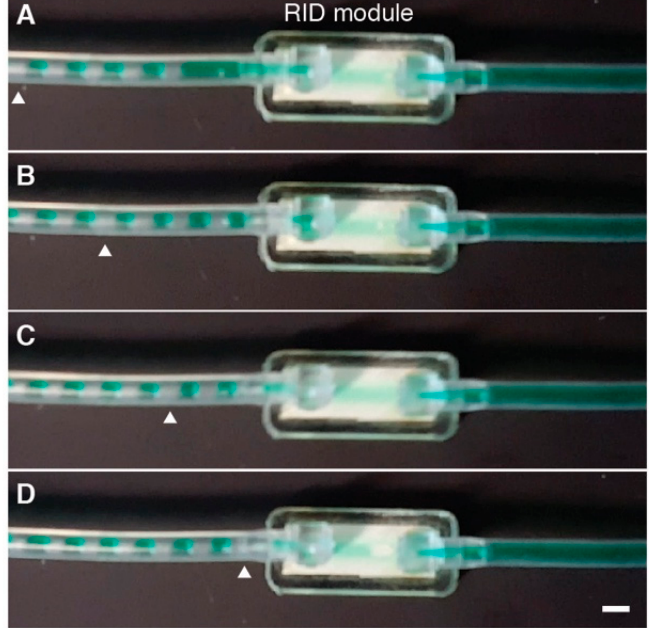
Figure 4. Sequential frames A-D extracted from video showing bubble removal from an incoming segmented flow stream (bubble volume = 2.2 ± 0.3 µ L, Q = 1.1 mL min − 1 , and V b :V T = 0.4). Flow is left to right. ( A ) White arrow highlighting bubble at left edge of frame, t = 0 s. ( B ) Segmented flow moving down tube toward RID, t = 0.73 s. ( C ) Bubbles upstream of highlighted bubble enter RID, t = 1.33 s. ( D ) Highlighted bubble close to the entrance of the RID module. Upstream bubbles have been removed and bubble-free flow leaves the module, t = 2 s. Bubble removal rate dV / dt = 440 µ L min − 1 . Scale bar = 3mm.